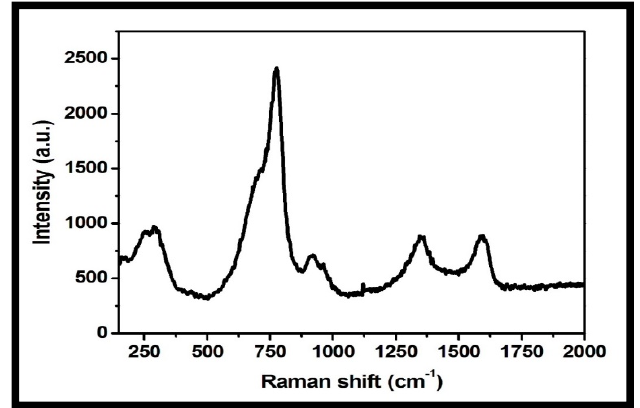
Figure 7. Typical Raman spectrum of the prepared rGO-WO 3 heterostructure.